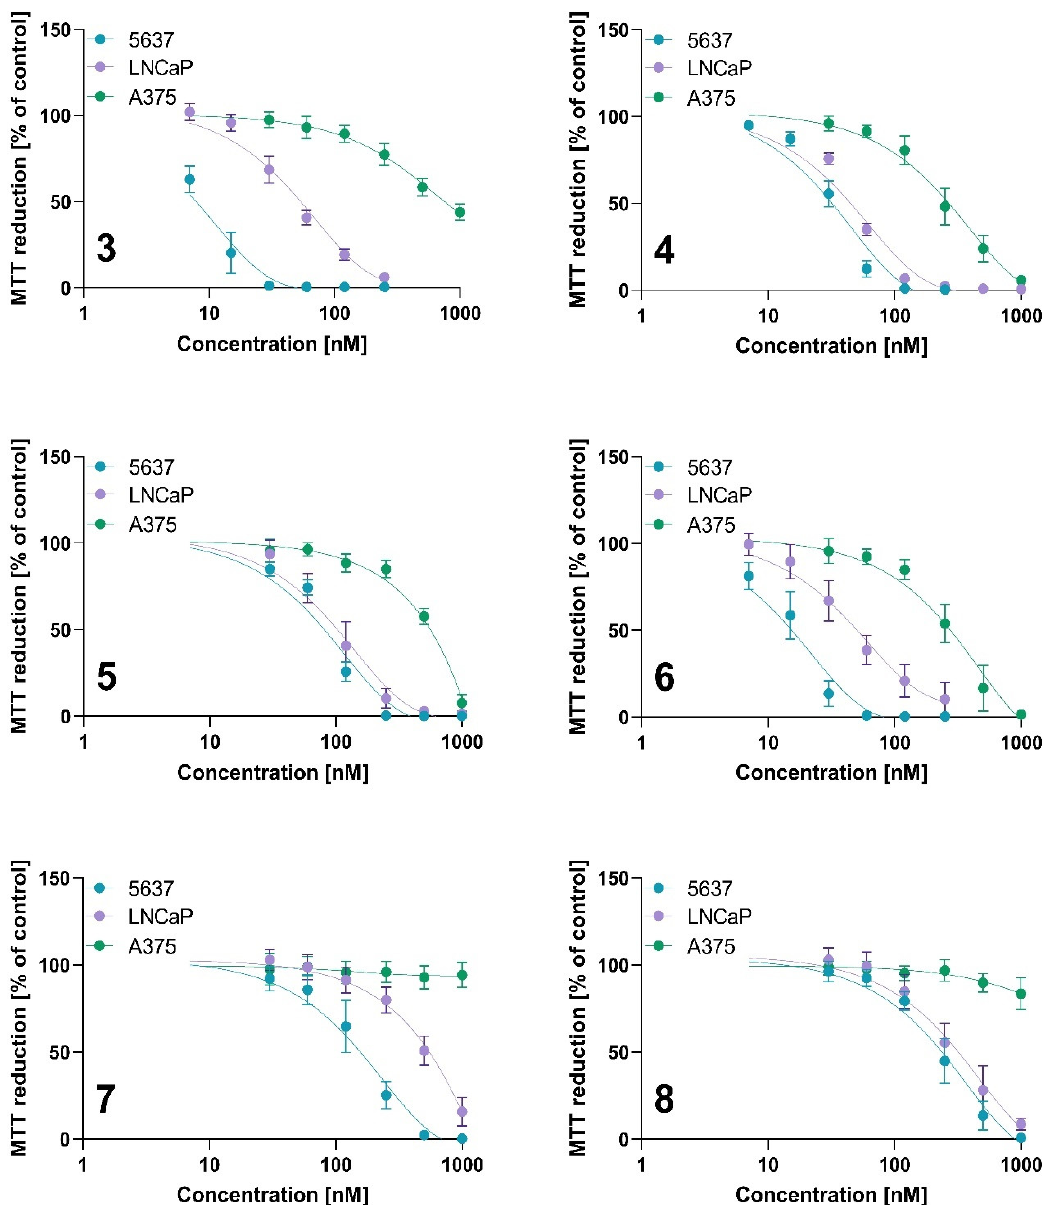
Figure 11. The phototoxicity of tested photosensitizers against 5637, LNCaP, and A375 cells for compounds 3 , 4 , 5 , 6 , 7 and 8 . After incubation with tested PSs, cells were irradiated at a light dose of 10 J/cm 2 . Cytotoxic effect was determined using the MTT assay. Data are expressed as the mean ± SD from at least three independent experiments.